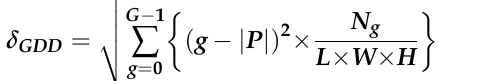
Figure 5. The principle of GDB : 𝒇 𝒂 (𝒙, 𝒚, 𝒛), 𝒇 𝒃 (𝒙, 𝒚, 𝒛) and 𝒇 𝒄 (𝒙, 𝒚, 𝒛) are the schematic diagram cor- responding to 𝜹 𝑮𝑫𝑩 20, 16, 11.31.